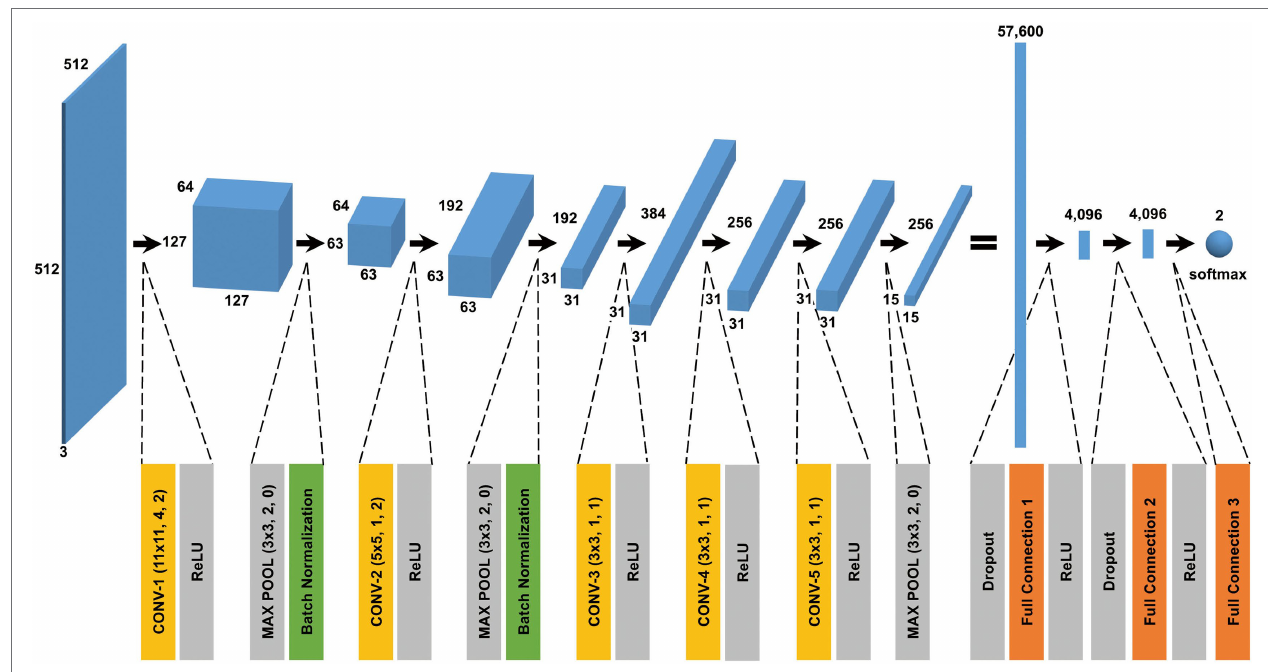
FIGURE 4 | CNN architecture used in this study. A batch normalized version of AlexNet was used for patch classification. The network architecture and some hyperparameters are illustrated in the figure. The input was a grayscale patch with a size of × 512 512 pixels whose values were copied into three channels. The first layer in the network was a 2-dimensional convolutional layer whose kernel was × 11 11 with stride 4 and padding 2, which produced values with a size of × × 127 127 64 (an image with a size of × 127 127 and 64 channels). The softmax function was used for the classification